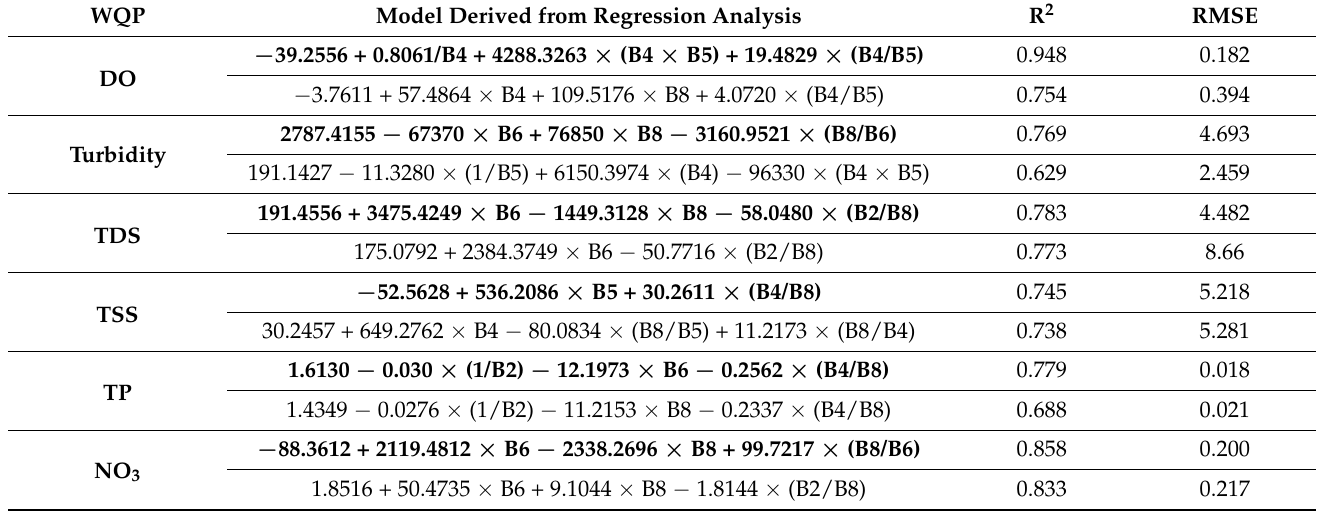
Table 3. Water quality models obtained from satellite image analysis. WQP Model Derived from Regression